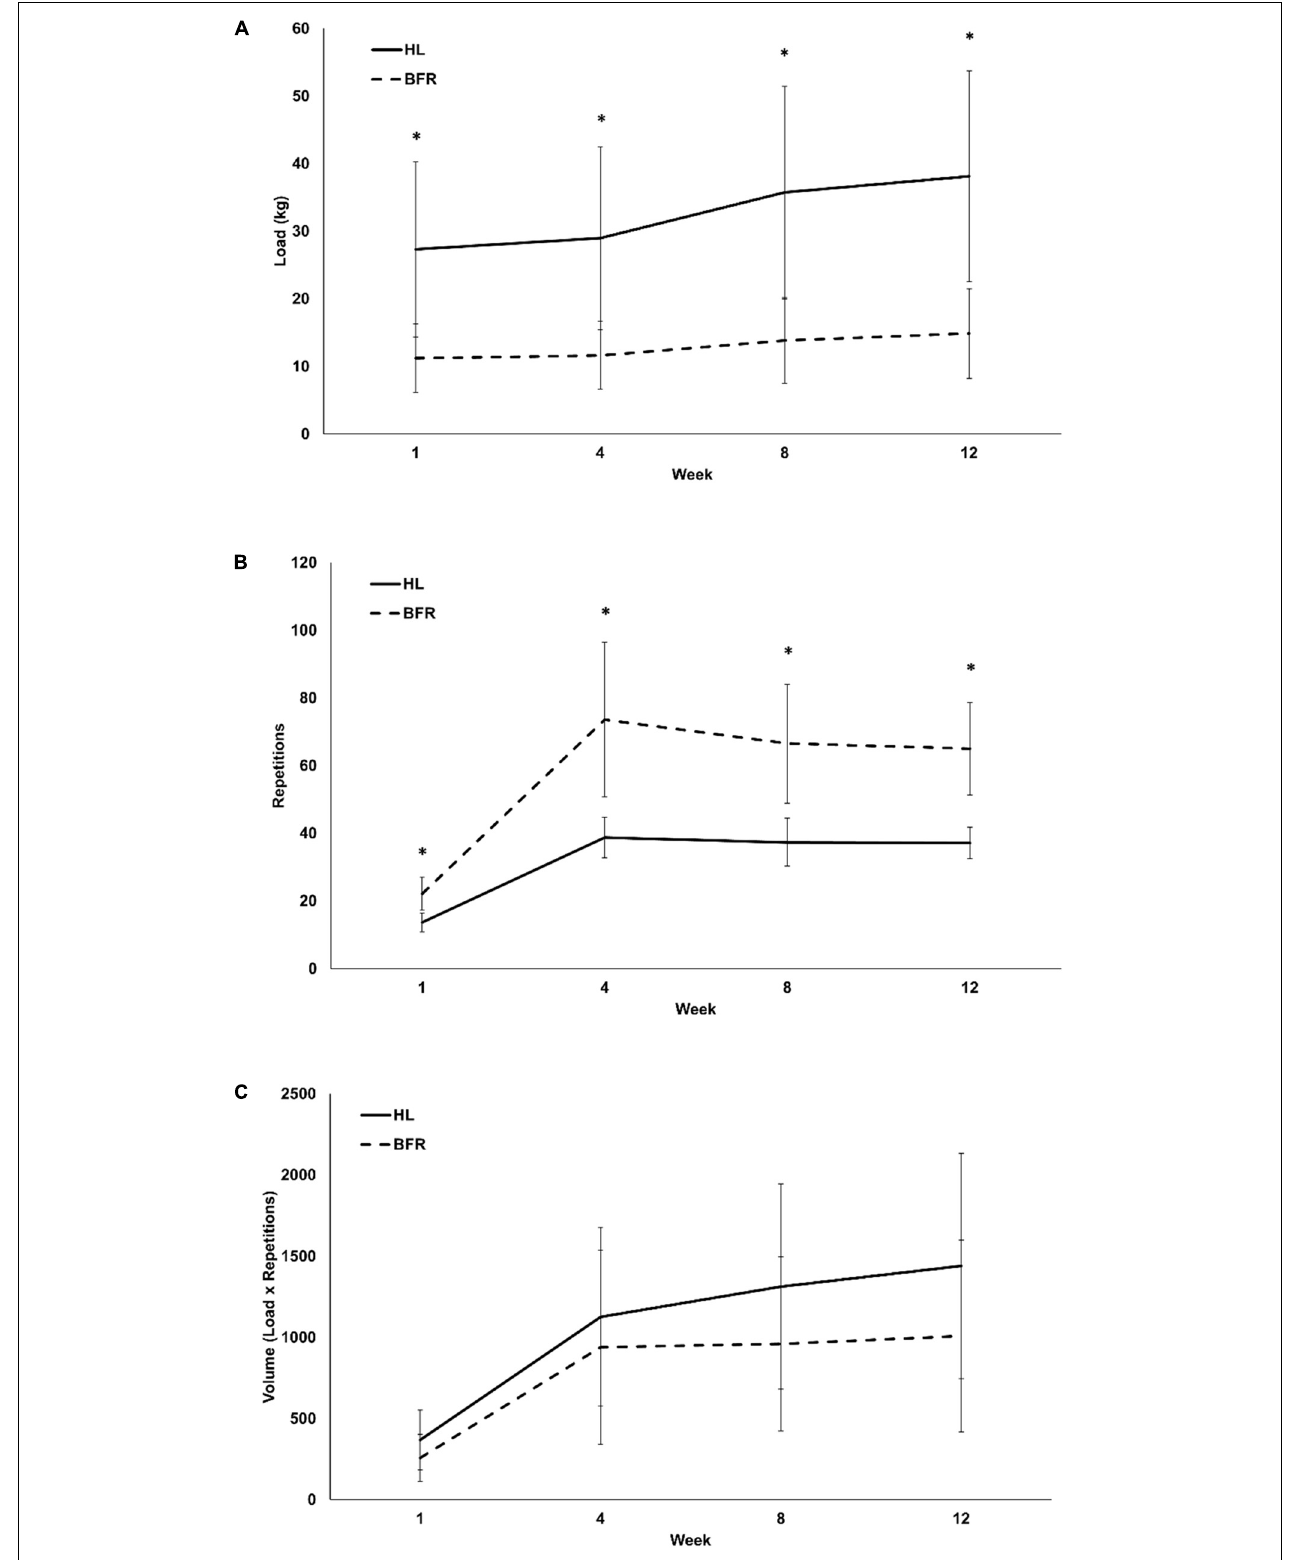
FIGURE 1 | Monthly load (A) , repetitions (B) , and volume (C) of high-load (HL) and low-load blood flow restricted (BFR) knee extension resistance training. ∗ denotes significant difference between HL and BFR.